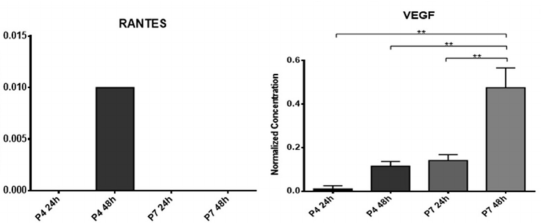
Figure 3. Normalized concentration of each biomarker in the conditioned medium of OM-MSCs in P4 and P7 (mean ± SEM). * corresponds to 0.01 ≤ p < 0.05, ** to 0.001 ≤ p < 0.01, *** to 0.0001 ≤ p < 0.001, and **** to p < 0.0001.